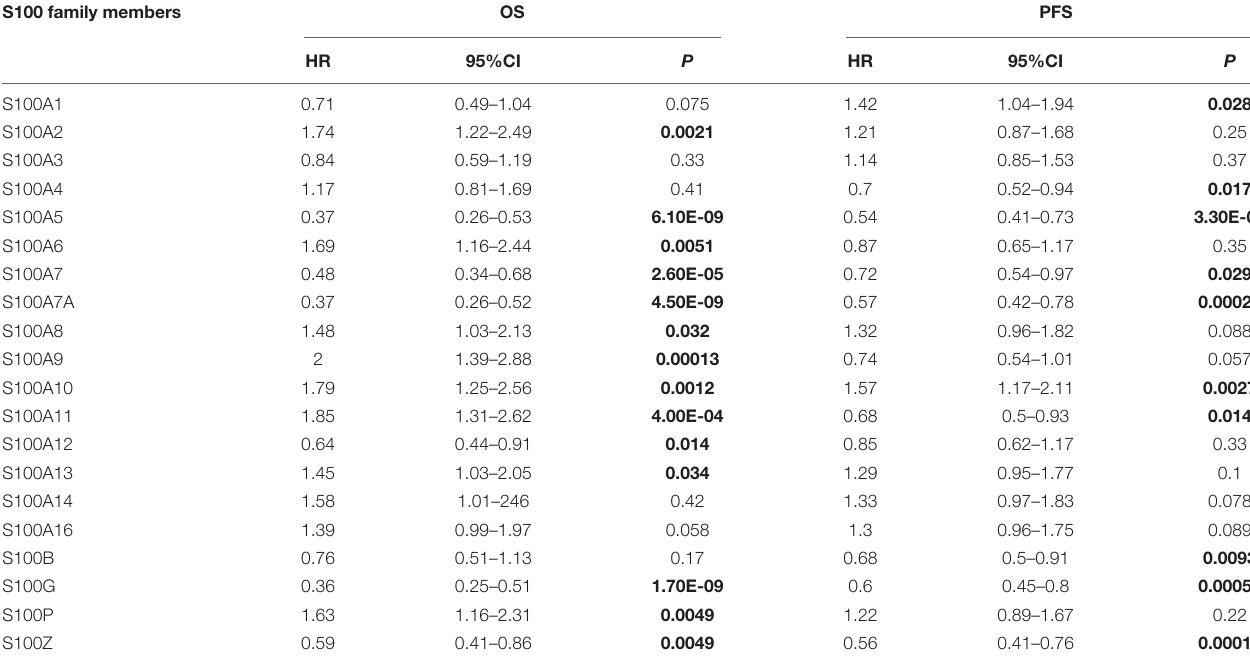
TABLE 2 | Prognosis roles of S100 family members (analyzed by Kaplan-Meier Plotter tools). S100 family members